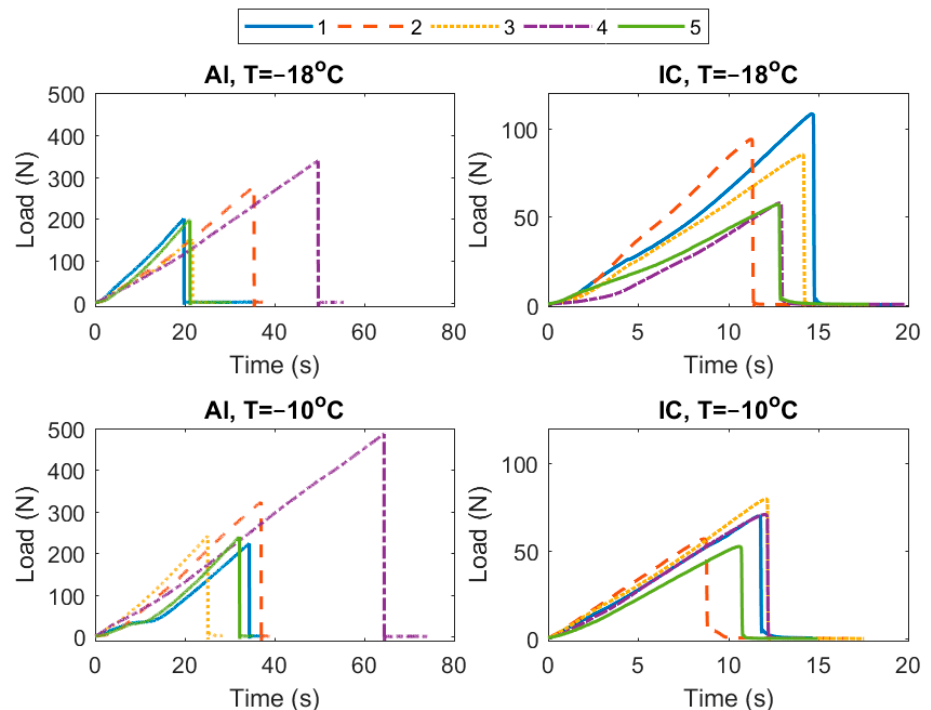
Figure 6. Force–time curves for VST ice adhesion measurements performed at NTNU. The maximum force was divided by the contact area of the ice sample to calculate the ice adhesion strength. All five samples for each surface and temperature are indicated.